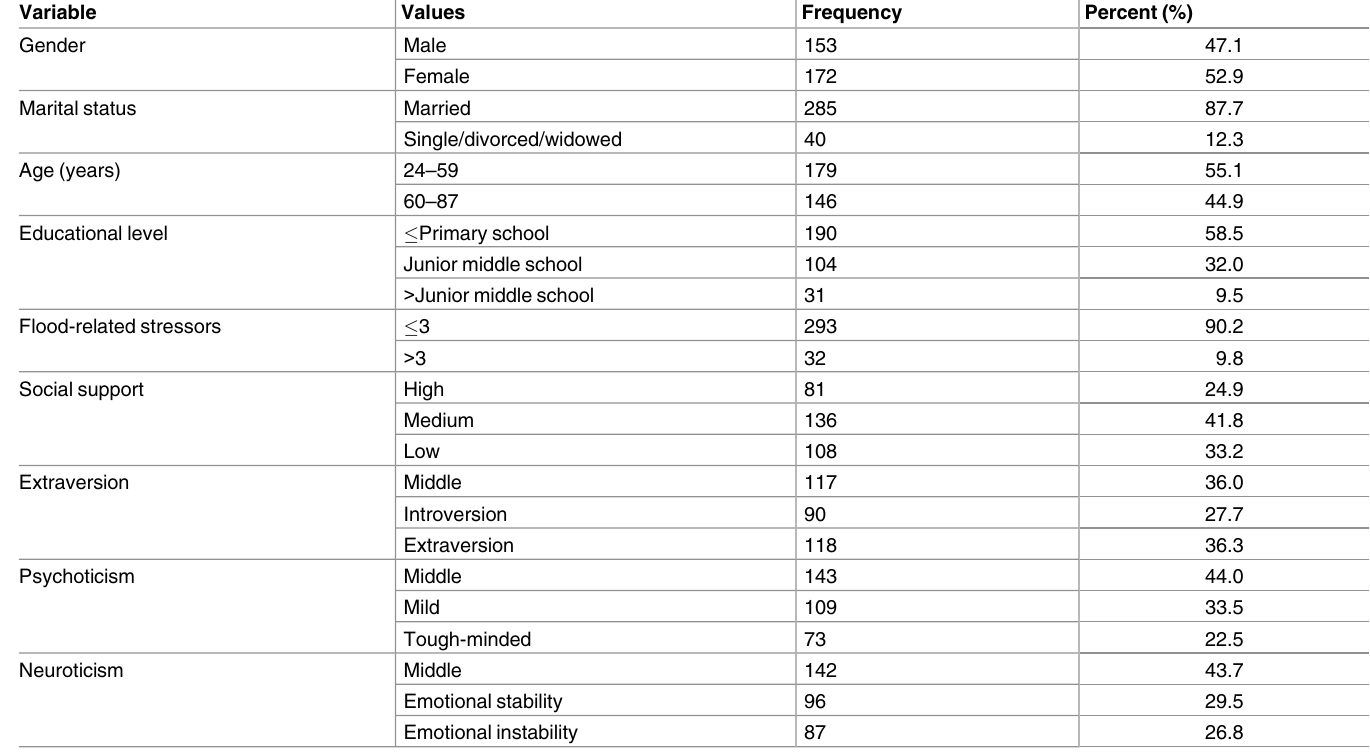
Table 1. Characteristics of the participants (n =